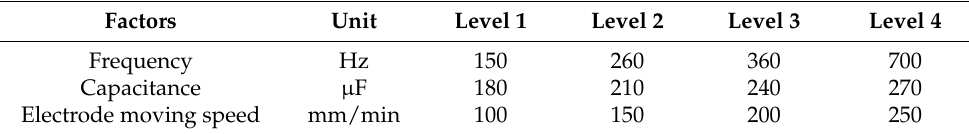
Figure 1. Illustration for CNC automatic electro-spark deposition ( a ) and photograph of an automatic electro-spark deposition experimental device ( b ). Frequency (f), capacitance (c), and electrode moving speed (v) were considered as process parameters for optimizing the coating quality criteria, which include coating thickness, coating coverage, and porosity in coating based on Taguchi L16 orthogonal ex ‐ perimental design, as shown in Table 1. Table 1. Design of Taguchi L16 orthogonal experimental parameters.